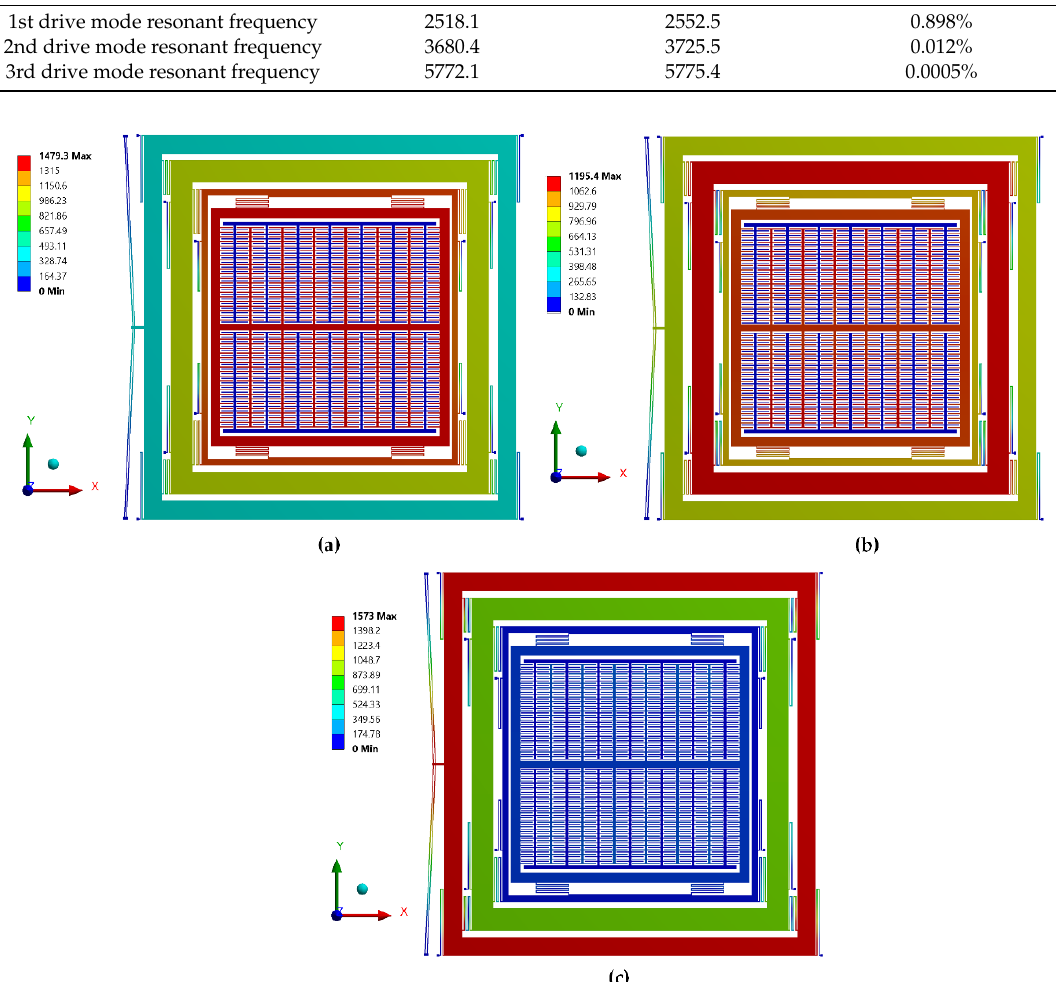
Figure 14. Combined modal analysis results of the overall 4-DOF proposed gyroscope dynamical model. ( a ) Mode shape at 1st drive mode resonant frequency. ( b ) Mode shape at 2nd drive mode resonant frequency. ( c ) Mode shape at 3rd drive mode resonant frequency.